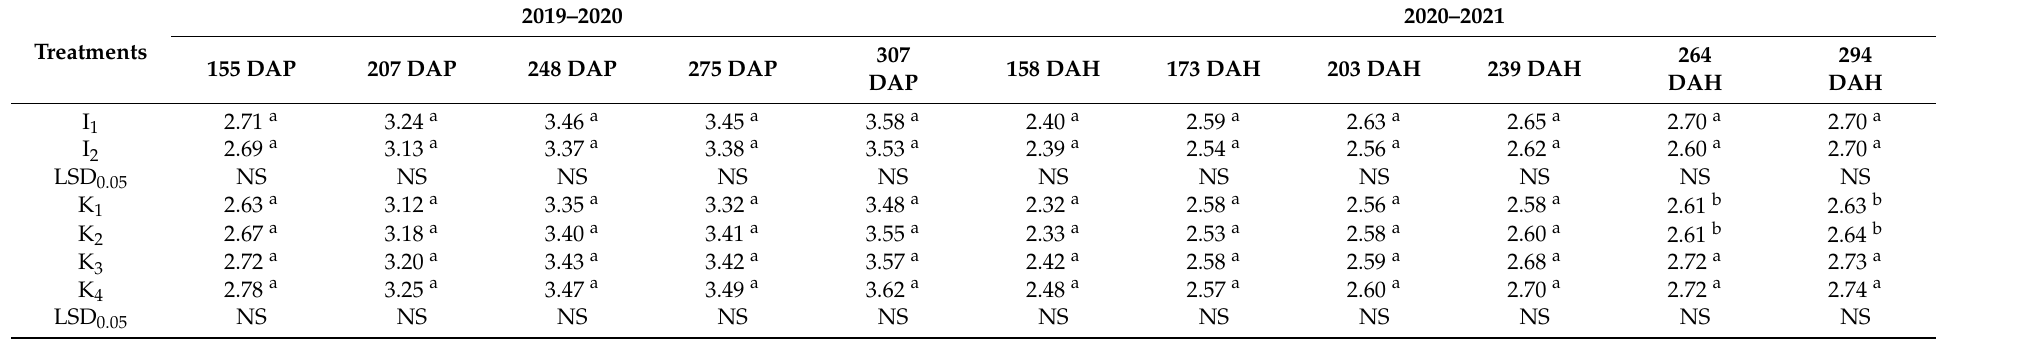
Table 6. Cane diameter (cm) as a function of irrigation and potash levels.